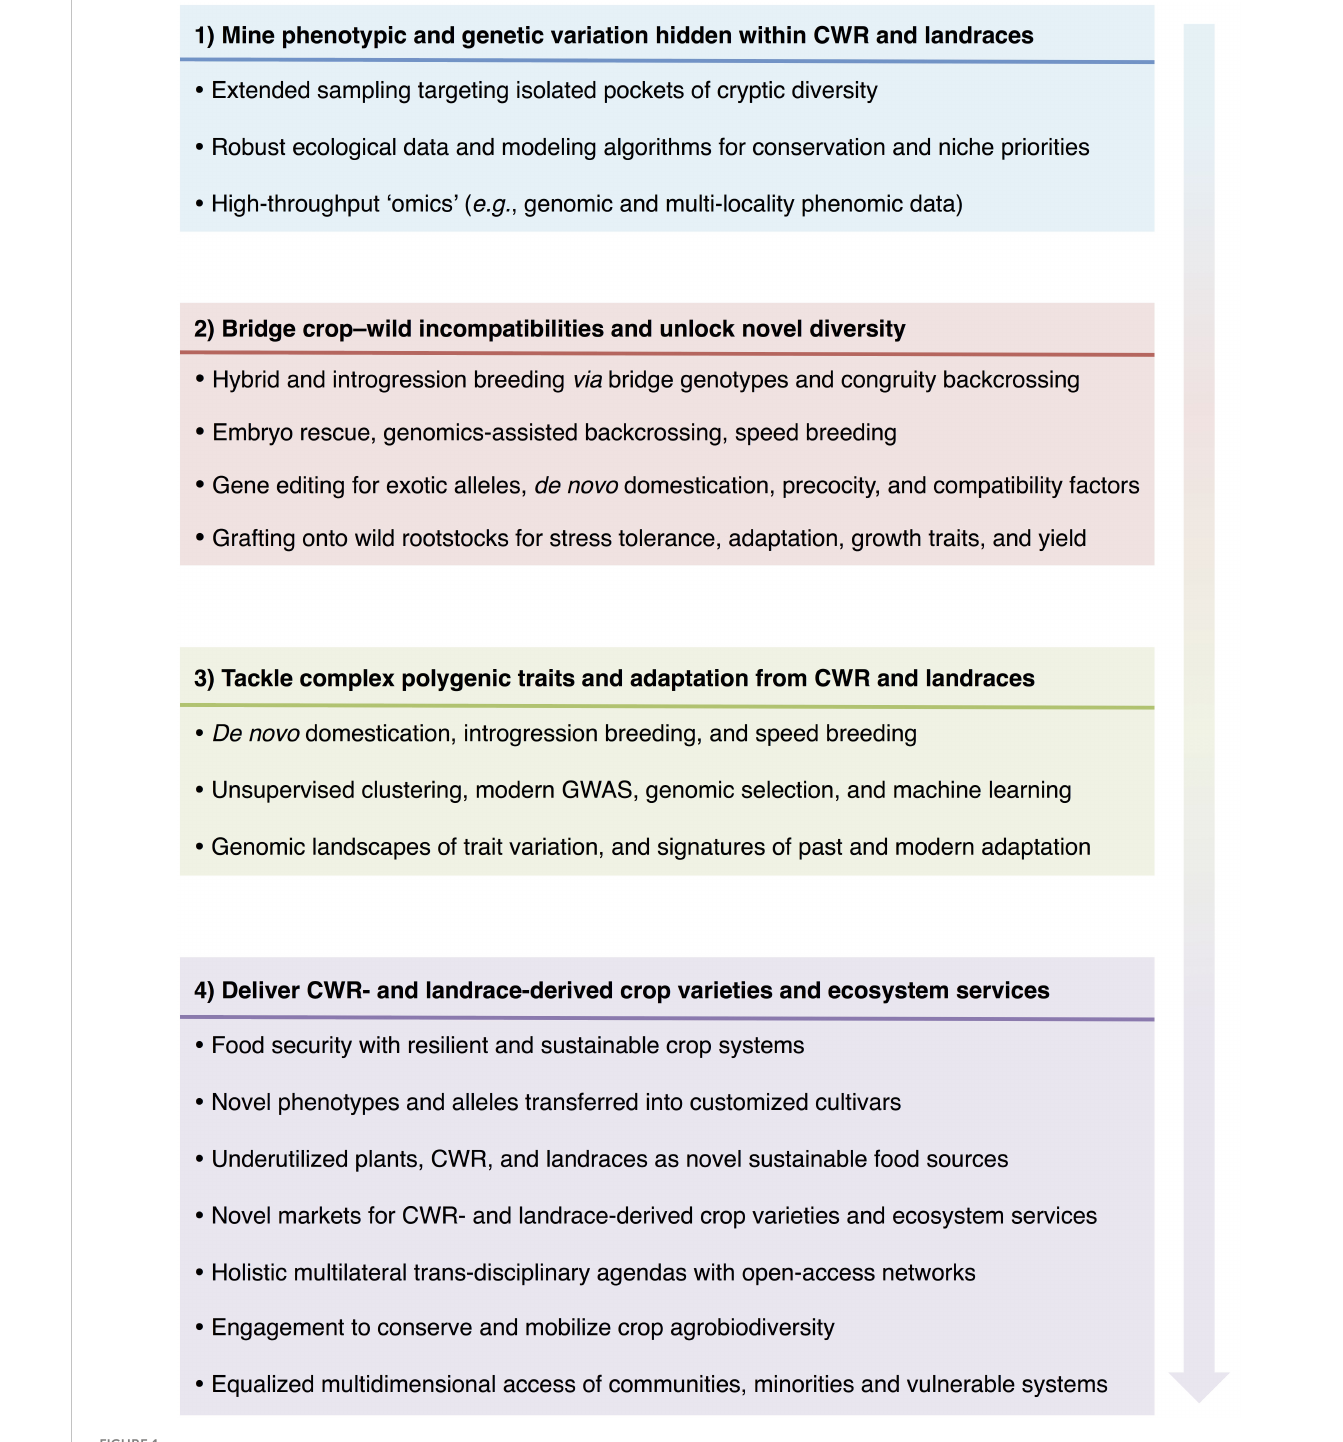
FIGURE 1 Schematic roadmap to harness genebanks. Each box marks pivotal research avenues (with the corresponding recommendations within) worth considering for mining, unlocking and utilizing phenotypic and genetic novelty hidden within crop wild relatives (CWR) and landraces. Ultimately, achieving food security with resilient and sustainable agrifood systems capable to cope with climate change, biodiversity loss, and increased pollution would require nature-based solutions for climate-smart alimentary schemes inspired in underutilized plant species, CWR, and